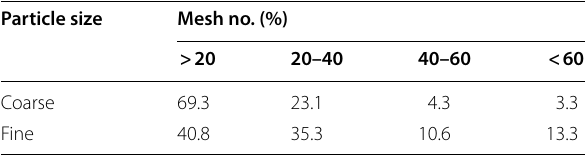
Table 1 Distribution of particle size of Broussonetia papyrifera based on mesh analysis